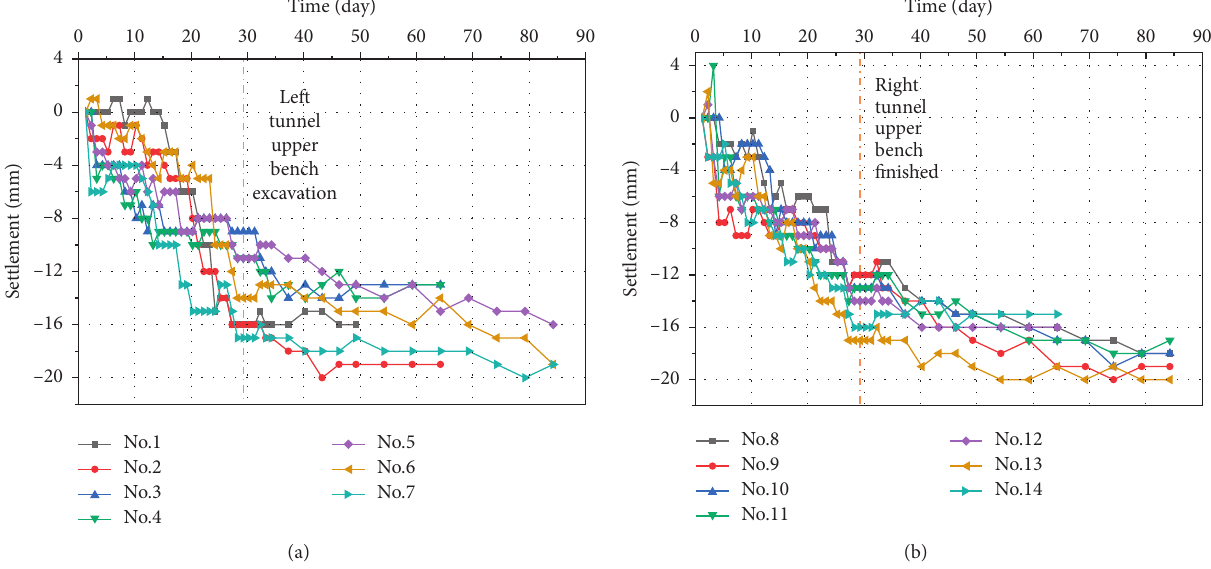
Figure 15: Ground surface settlement history curves of all measuring points. (a) Ground surface settlement history curves of measuring points on top of left tunnel. (b) Ground surface settlement history curves of measuring points on top of right